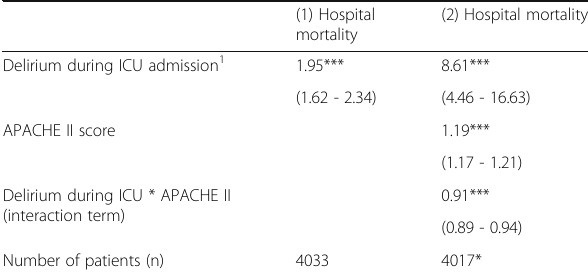
Table 55 (abstract A148). Association delirium - hospital